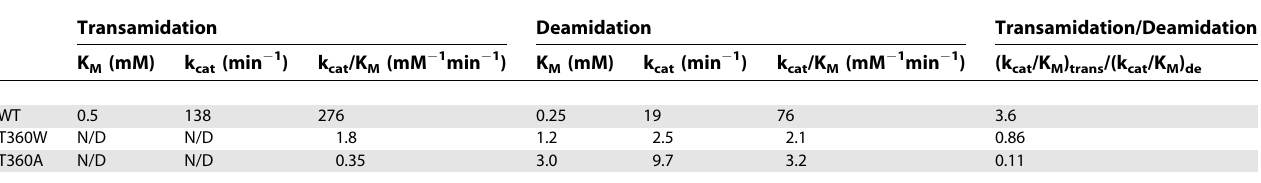
Table 2. Kinetic Parameters of Wild-Type TG2, T360W, and T360A Mutants Using Ac-PQLPF-NH 2 as the Acyl-Donor and Putrescine as the